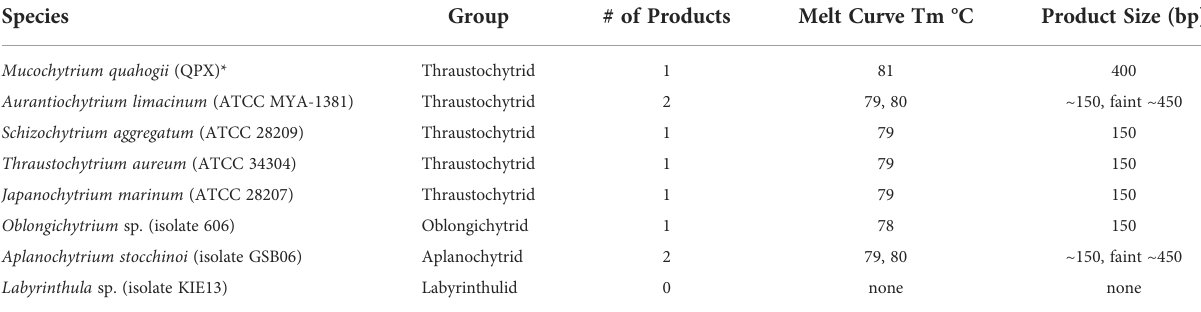
TABLE 1 Results from melt curve and gel electrophoresis analyses from the nqPCR assay ’ s analytical speci fi city testing. Species Group # of Products Melt Curve Tm °C Product Size (bp)